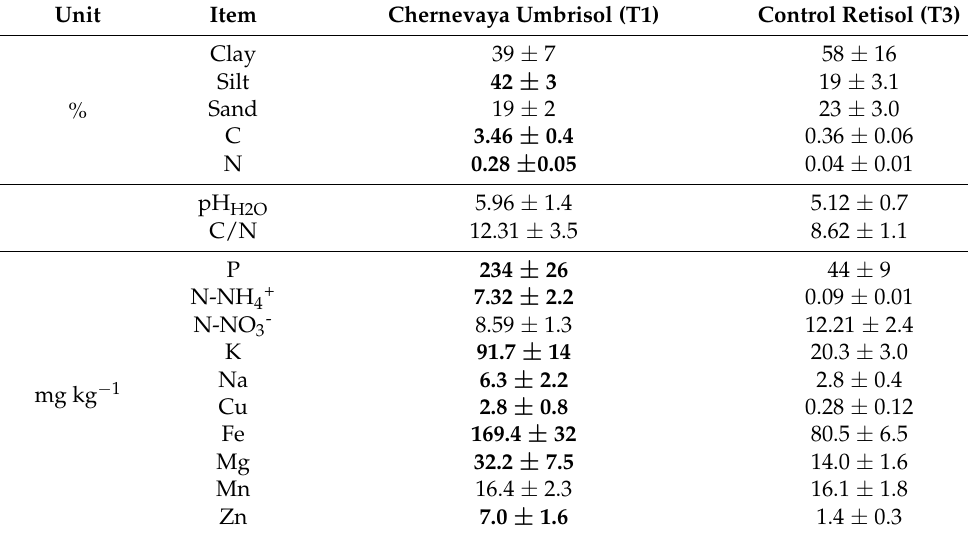
Table 1. General soil parameters of experimental plots, average of 5 replicates +/ − SE. The most significant differences ( t -test, p -value ≤ 0.05) are highlighted in